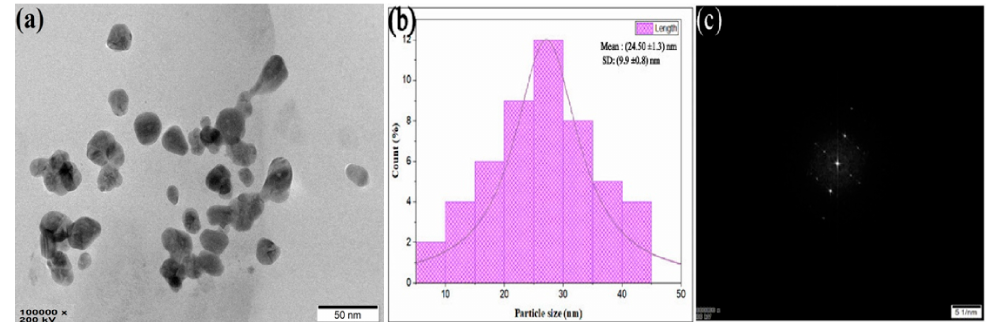
Figure 7. ( a ) TEM image, ( b ) histogram showing particle size distribution, and ( c ) SAED pattern image of biosynthesized LnFb-AgNPs from L. nepetifolia flower bud extract.